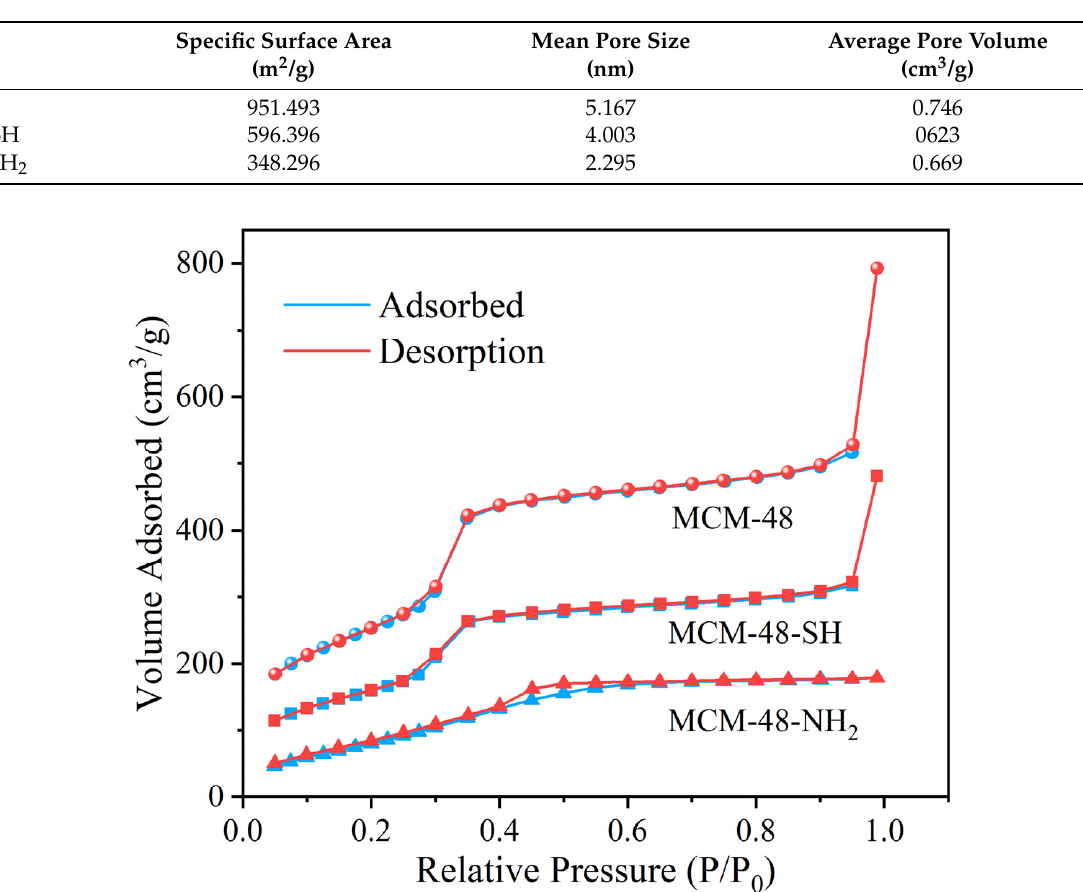
Table 1. Specific surface area, average pore diameter, and average pore volume of MCM-48, MCM- 48-SH, and MCM-48-NH 2 .